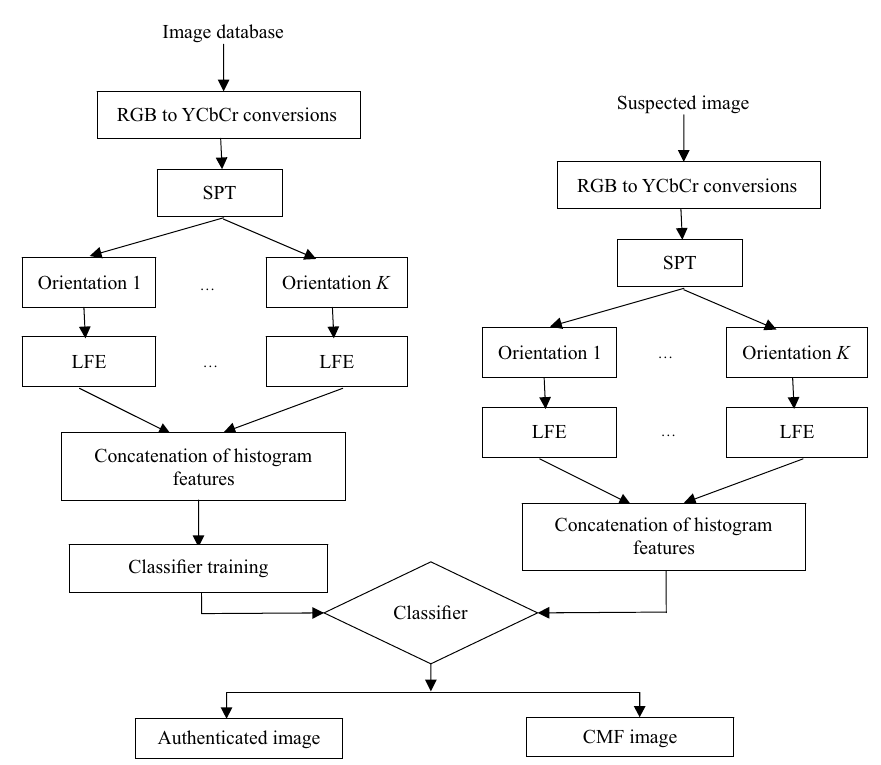
Fig. 6 Flow diagram of the proposed CMFD